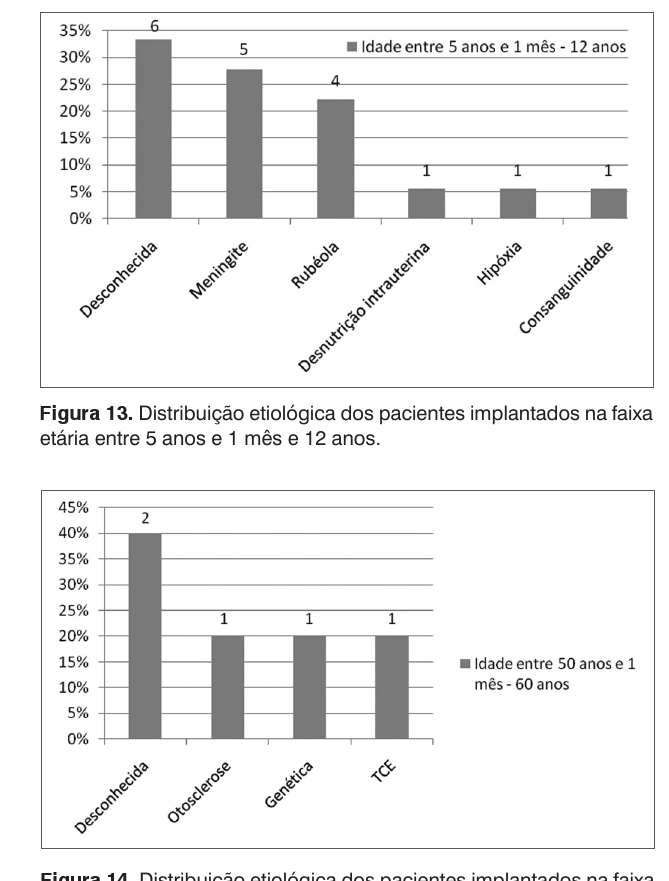
Figura 14. Distribuição etiológica dos pacientes implantados na